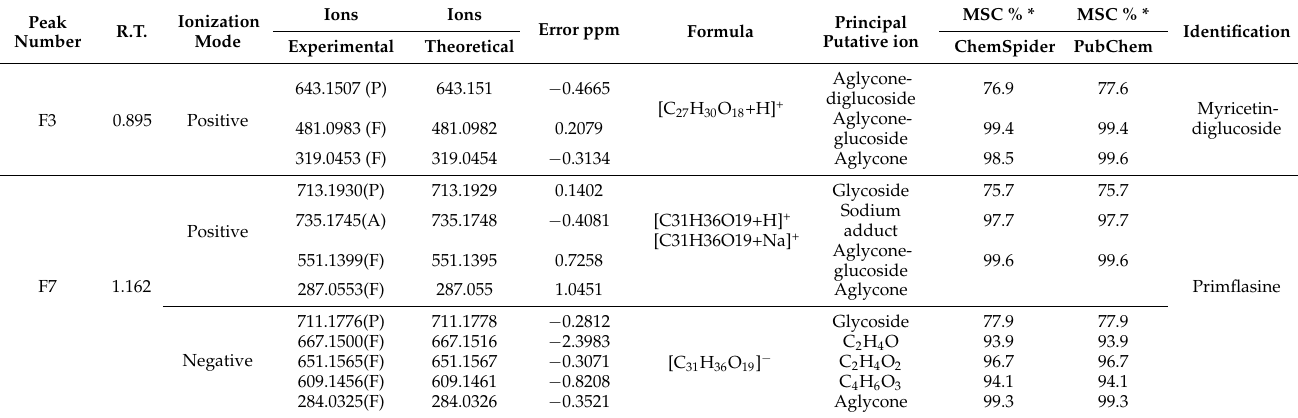
Table 2. Identification of unknown molecules by HRMS analysis.